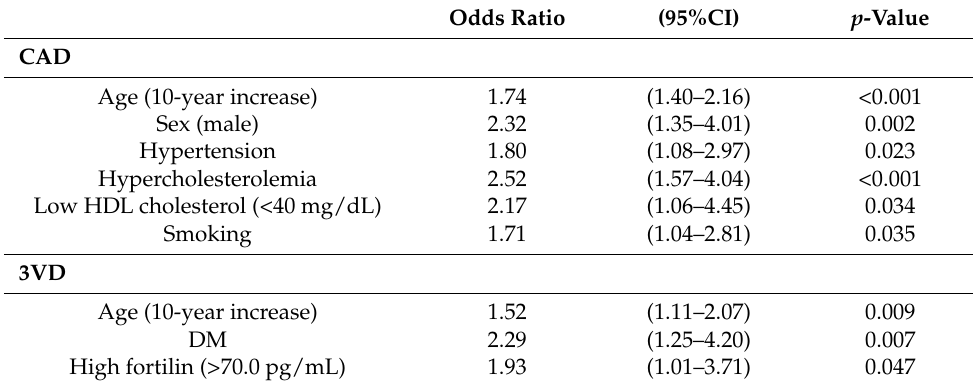
Table 2. Factors for CAD and